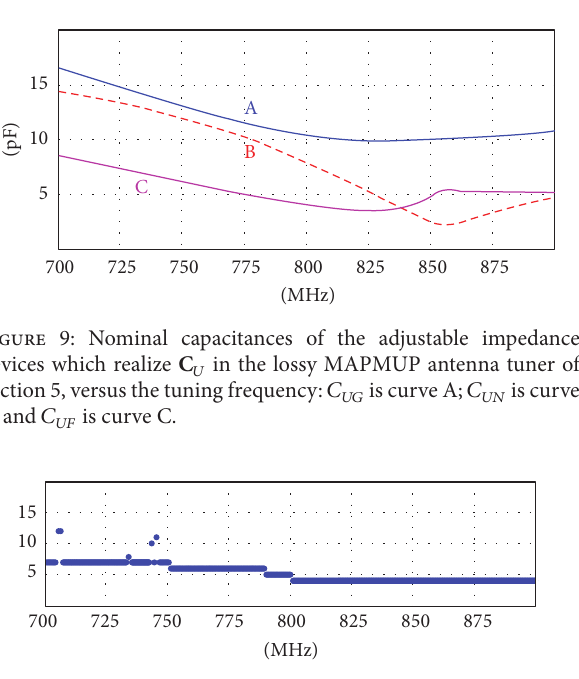
Figure 10: Number of iterations used in the tuning computation.